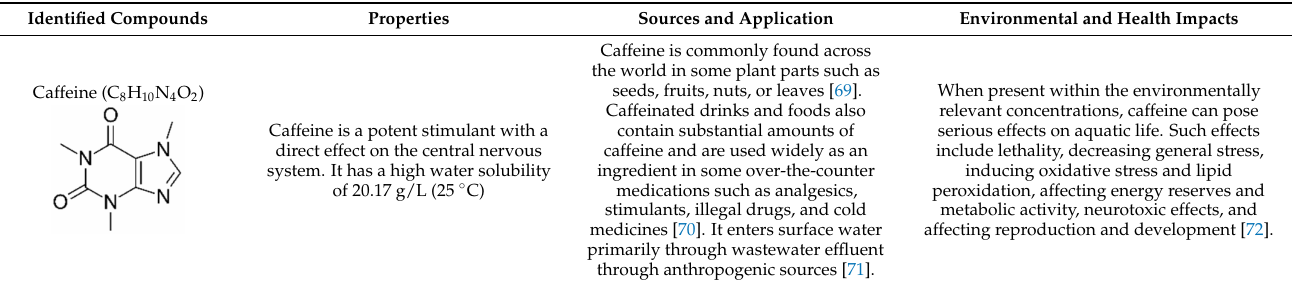
Table 4. Other qualitatively identified compounds in wastewater